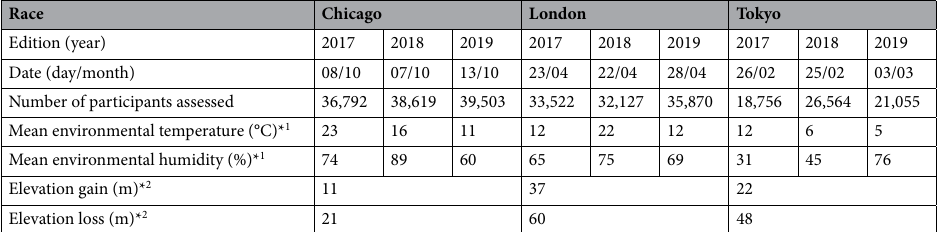
Table 1. Characteristics of the marathons assessed. * 1 Environmental conditions were obtained for Tokyo from the official website of the marathon, and for London and Chicago from the website https:// www. timea nddate. com. * 2 Elevation gain and loss were obtained from the data of a runner that performed all the marathons (Garmin 920XT, Garmin Ltd, Switzerland).